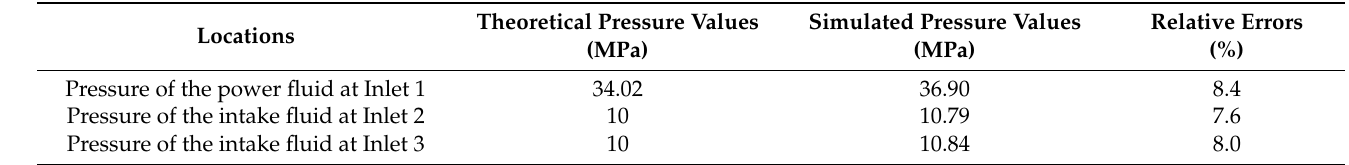
Table 2. Verification of the accuracy of simulation results.